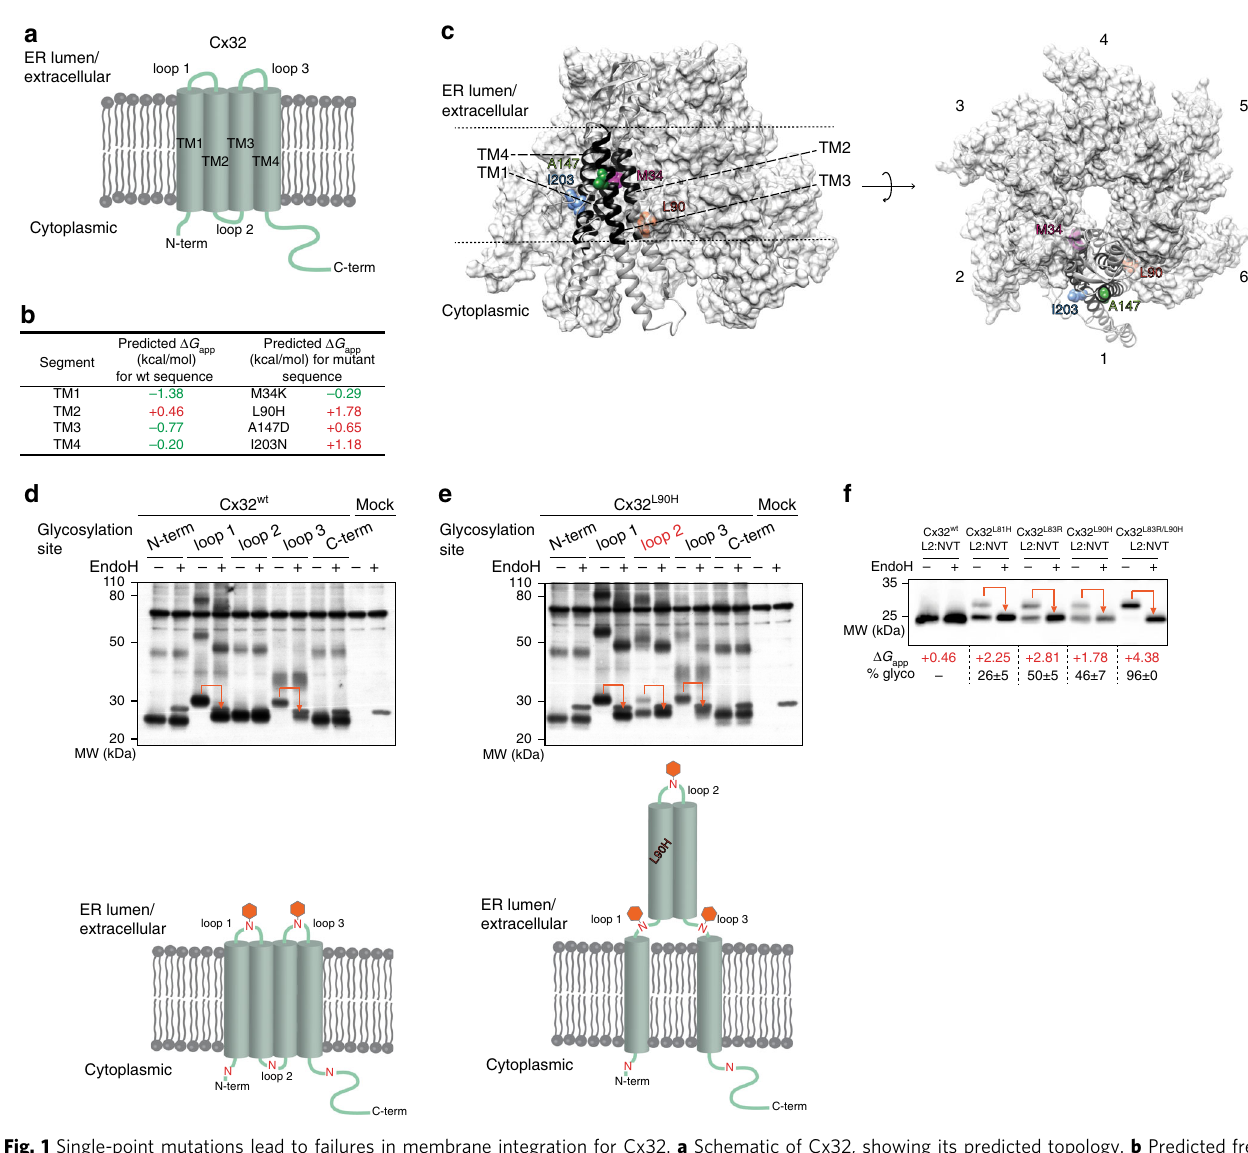
Fig. 1 Single-point mutations lead to failures in membrane integration for Cx32. a Schematic of Cx32, showing its predicted topology. b Predicted free energies for helix insertion for apolar-to-polar missense mutations investigated in this study. For Δ G < 0 (green) an energetically favorable membrane integration is predicted, while Δ G > 0 (red) indicates an unfavorable insertion reaction. Transmembrane helices and Δ G values were predicted according to Hessa et al. 17 . c Side and top view of the modeled hexameric Cx32 connexon. Disease-causing mutants investigated in this study are shown in a CPK representation on a single monomer. Transmembrane helices are shown in black. Individual Cx32 monomers are numbered from 1 to 6. d Cx32 wt and e Cx32 L90H with individually introduced glycosylation sites in the indicated regions were transfected into HEK293T cells, lysates treated with or without EndoH as indicated and analyzed by immunoblotting. The schematics below each indicate the location of the individually assessed glycosylation sites (N) and possible topologies deduced from the observed glycosylation. An orange arrow in the blots and an orange hexagon in the schematic indicate sites that became glycosylated. f HEK293T cells transfected with the indicated Cx32 TM2 mutant constructs were analyzed as in d , e . Constructs all carried a glycosylation reporter site in loop 2 (L2:NVT). Predicted free energies of membrane insertion for TM2 of the respective proteins as well as a quanti fi cation of relative loop 2 reporter site glycosylation (mean ± SEM, N = 3) are shown below the